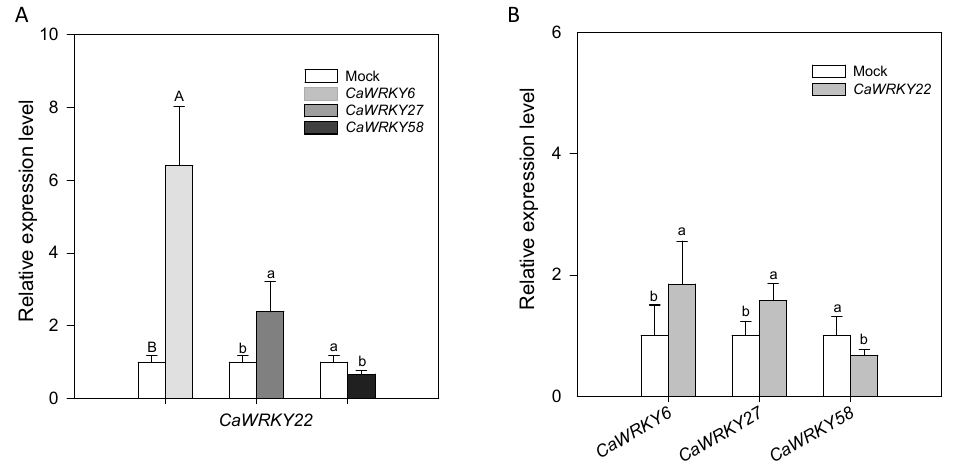
Figure 8. The inter-relationship between CaWRKY22 and CaWRKY6 , CaWRKY27 and CaWRKY58 . ( A ) Transcriptional expression of CaWRKY22 in pepper leaves transiently overexpressing CaWRKY6 , CaWRKY27 , and CaWRKY58 at 24 hpi. The expression level of CaWRKY22 in pepper leaves transiently overexpressing the mock (empty vector) was set to “1”; ( B ) transcriptional expression of CaWRKY6 , CaWRKY27 , and CaWRKY58 in pepper leaves transiently overexpressing CaWRKY22 at 24 hpi. The relative expression level of target genes in mock treated plants (empty vector) was set to “1”. Data represents the means ± SD from four biological replicates. Error bars indicated the standard error. Different letters on the bars indicate significant differences between means, as determined by Fisher’s protected LSD test: uppercase letters, p < 0.01; lower case letters, p < 0.05.